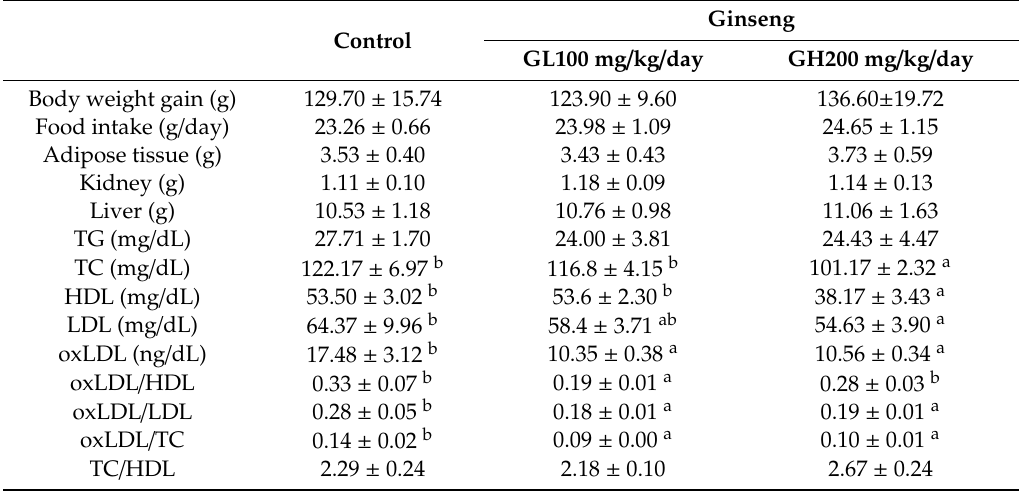
Table 1. General characteristics of rats fed a normal diet with or without ginseng administration.